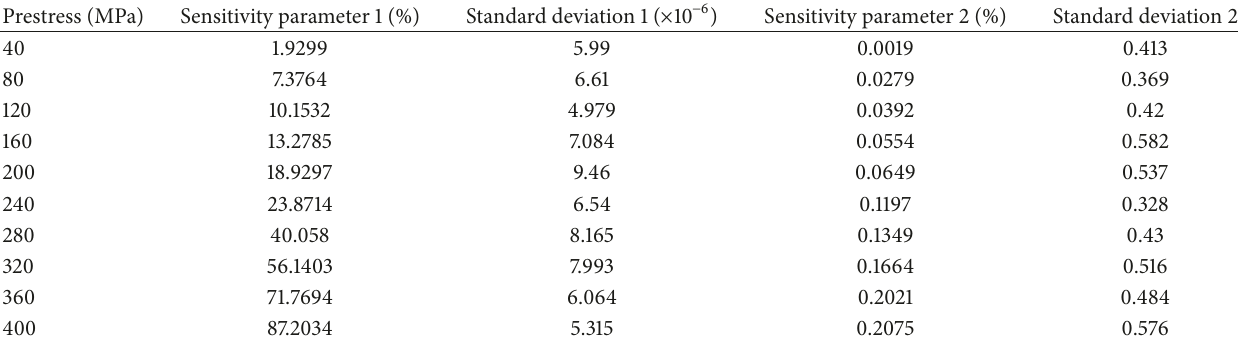
Table 1: Sensitivity parameters of the relative nonlinear coefficient and wave velocity for stress.